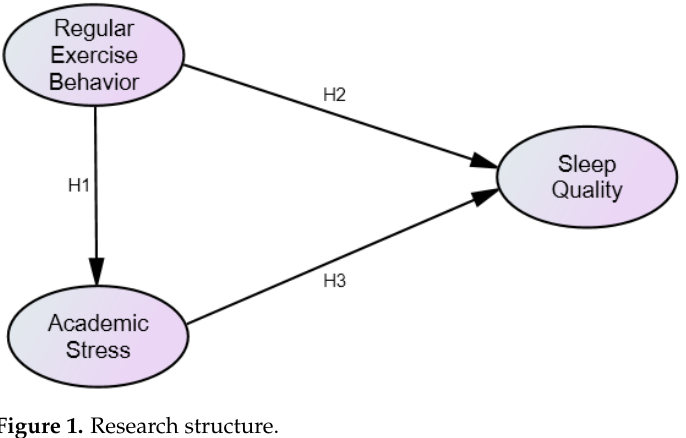
Figure 1. Research